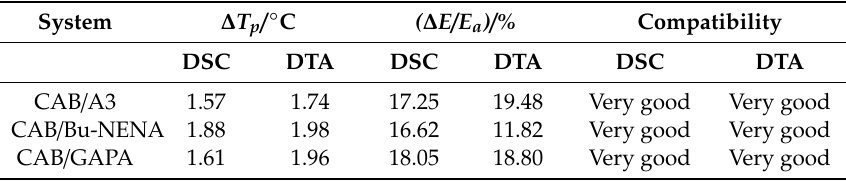
Figure 5. Di ff erential scanning calorimetry (DSC) ( a ) and di ff erential thermogravimetric analysis (DTA) ( b ) curves of CAB, three plasticizers and the CAB / plasticizer systems at the heating rate of 10 K / min. Table 4. ∆ T p and ∆ E / E a of di ff erent CAB / plasticizer systems and the corresponding compatibility obtained from DSC /